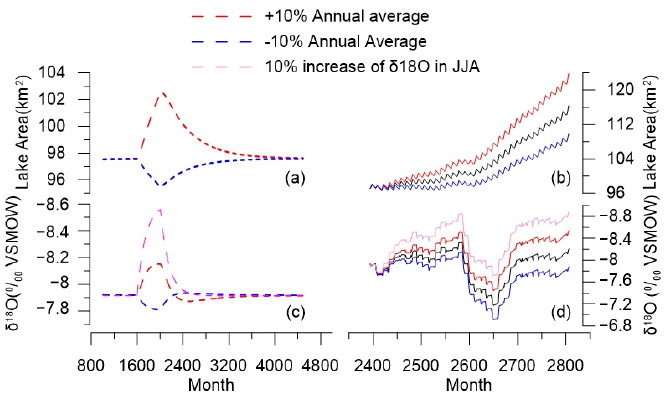
Figure 4. Sensitivity analysis results for precipitation amount and isotopic composition of precipitation. ( a ) Lake area change response to precipitation variation at steady status; ( b ) lake area change response to precipitation variation at transient status; ( c ) δ 18 O of lake water change response to precipitation variation at steady status; and ( d ) δ 18 O of lake water change response to precipitation variation at transient status.